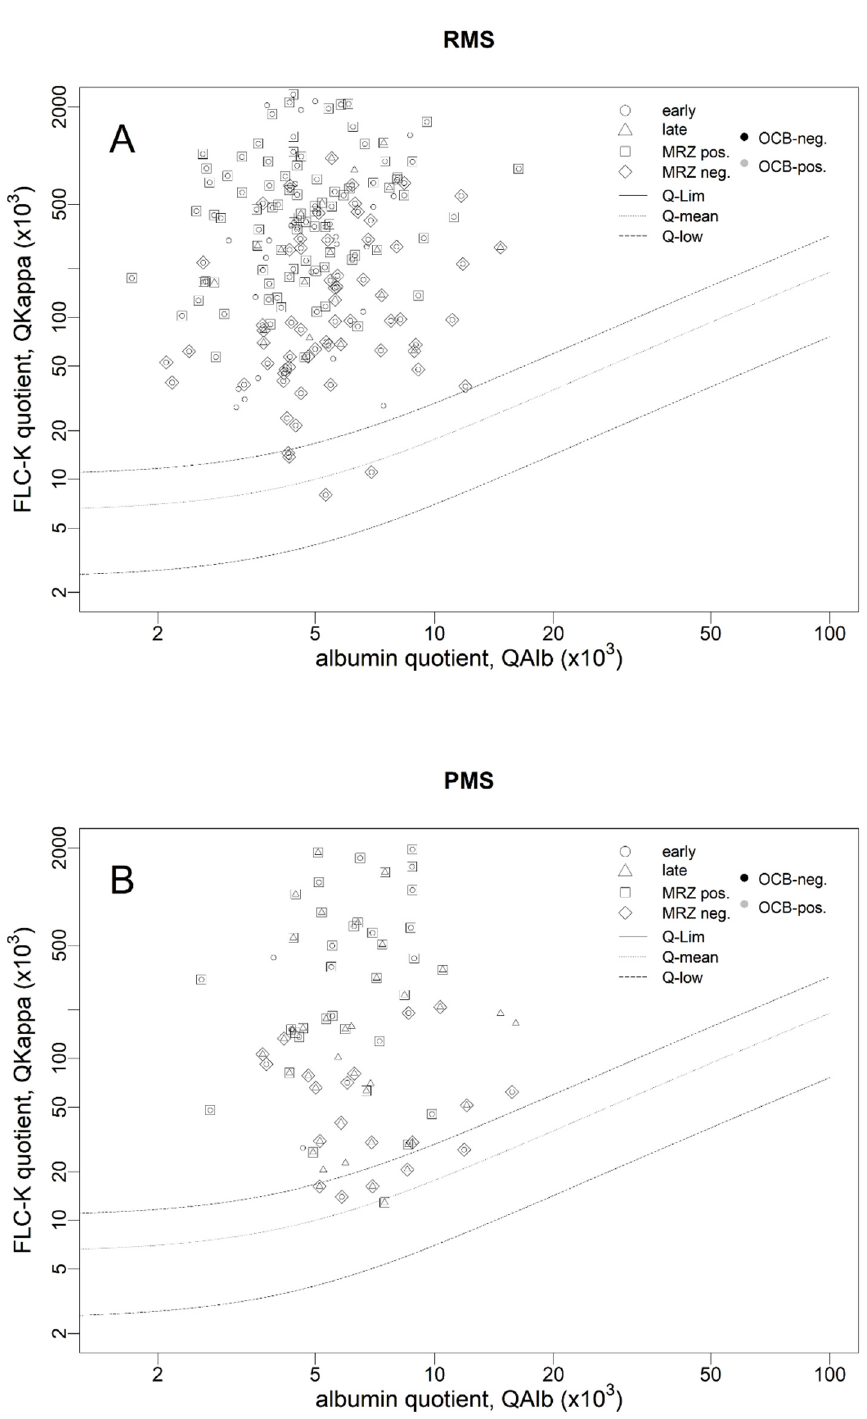
Figure 2. FLCk quotients of the RMS cohort ( A ) and PMS cohort ( B ) in double logarithmic free light chain kappa (FLCk) quotient diagrams. OCB positivity is represented by black and negativity by grey coloration. Circles represent early onset, triangles late onset MS squares represent samples with MRZ positivity, rhombus MRZ negativity. ( A ) In RMS patients, 98% of the QFLCk values are above the Q FLCk (lim) reference range in early onset and in 100% in late onset RMS. ( B ) In PMS patients, 90% of the QFLCk values are above the Q FLCk (lim) reference range in early onset and in 92% in late onset PMS. IF = intrathecal fraction, FLCk = free light chains kappa, MS = multiple sclerosis, RMS = relapsing MS, PMS = progressive MS, OCB = oligoclonal bands, and MRZ = measles, rubella, and zoster reaction .